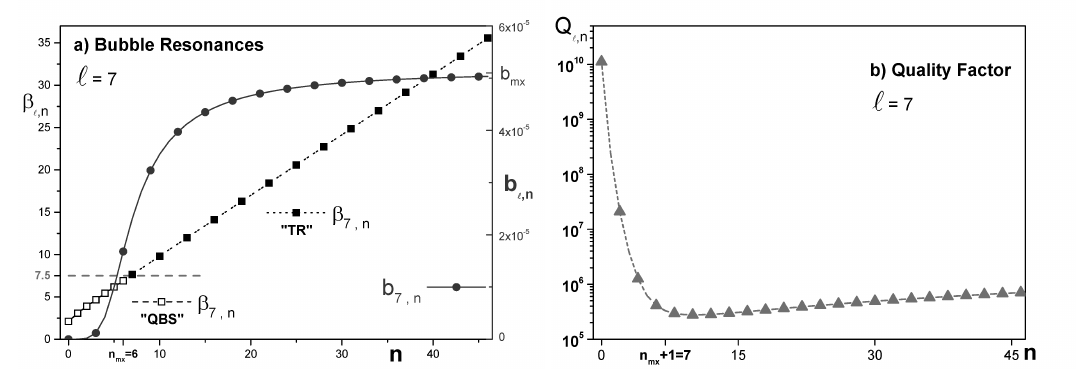
Figure 8 - Similar to Fig. 7, but for multipole (cid:96) = 7 this figure in ( a ) shows as function of the resonance order n the resonance positions ( β (cid:96),n , left vertical axis) as well as the widths ( b (cid:96),n , right vertical axis) for the Bubble’s Quasi-Bound State (QBS) and Transmission (TR) Resonances. The panel ( b ) shows the behavior of the Q (cid:96),n –factor as n